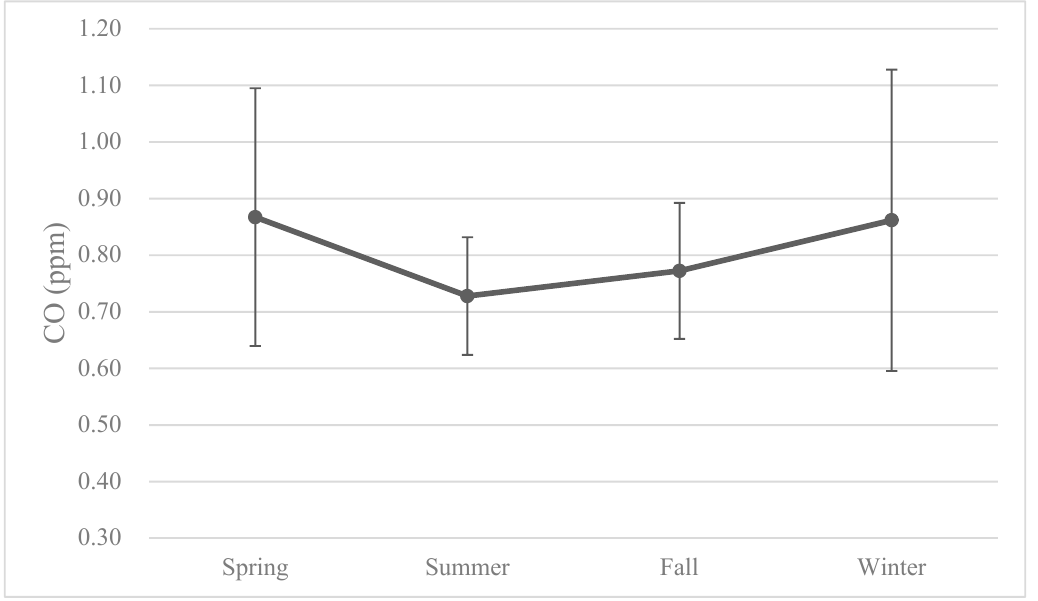
Figure 3. The monthly averages of air pollutant levels over the years of birth of the study cohort.